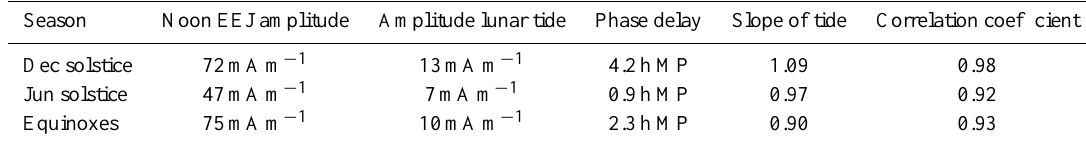
Table 2. The same as Table 1, but for the period August 2005–2010.